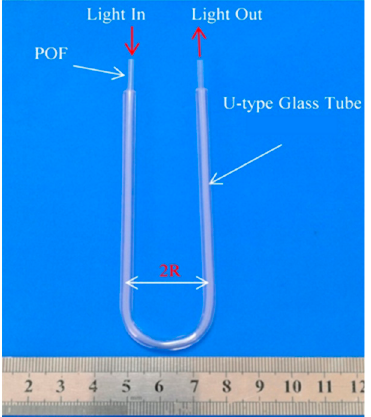
Figure 5. U-shaped plastic optical fiber fixing device.